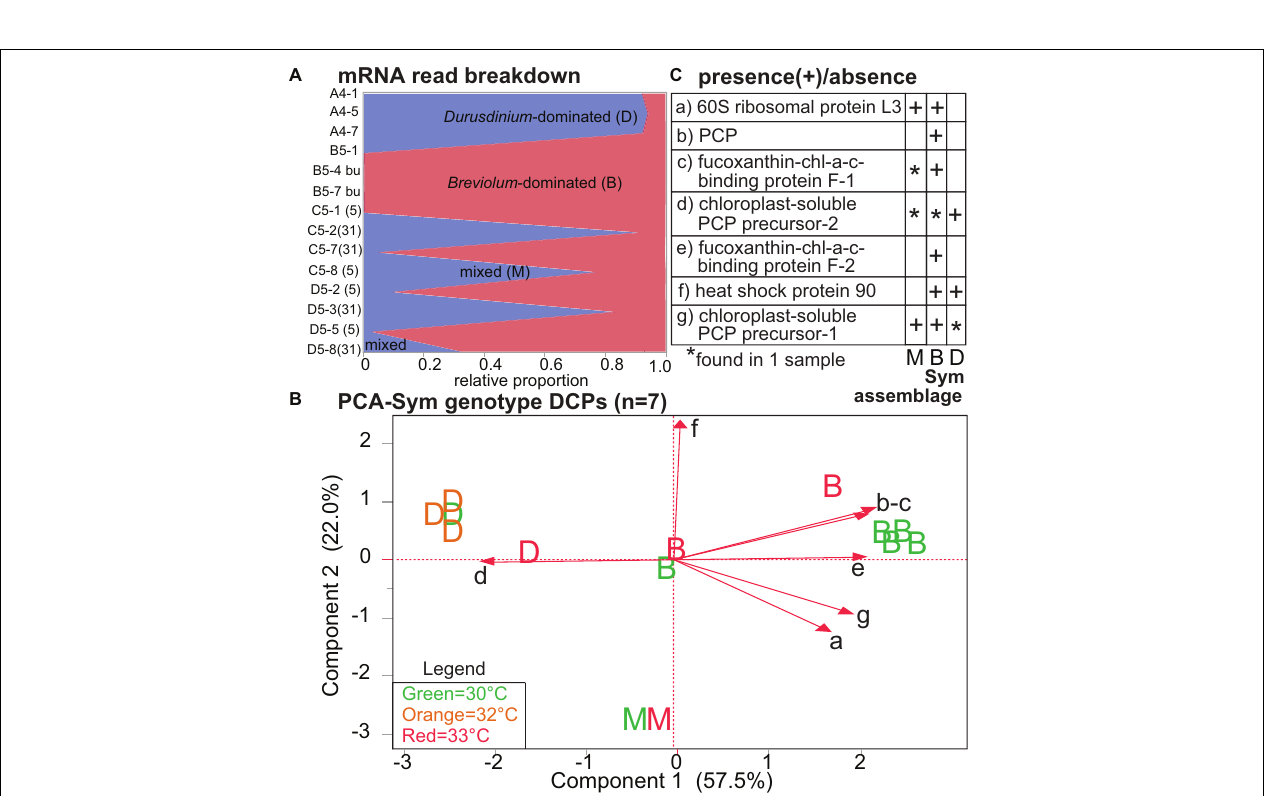
FIGURE 6 | Proteomic differences across Symbiodiniaceae (Sym) lineages. In the mRNA breakdown of the 14 samples analyzed by shotgun proteomics (A) , the blue and red shading reflect the proportions of Durusdinium spp. (“D”) and Breviolum spp. (“B”) dinoflagellates, respectively. Samples for which no genus comprised > 80% of the mapped mRNA reads were deemed “mixed-lineage” (“M”). The numbers in parentheses following the sample codes for the two genotypes that underwent endosymbiont shuffling, C5 [black(a) from Little Conch (offshore)] and D5 [grey60 from Cheeca Rocks (inshore)], represent sampling days. A PCA with seven proteins whose concentrations differed significantly across Sym assemblages (B) ; letters correspond to Sym assemblages, and the colors correspond to temperatures (see inset legend.) The black, small-font, lower-case letters adjacent to the biplot rays correspond to the row where the respective data for each protein have been displayed in (C) . Five, one, and one of these proteins were involved in photosynthesis (71.4%), the stress response (14.3%), and translation (14.3%), respectively. chl = chlorophyll. PCP = peridinin chl-a binding protein. For details on these nine proteins, please see Table 4 and Supplementary Tables 3, 5 .